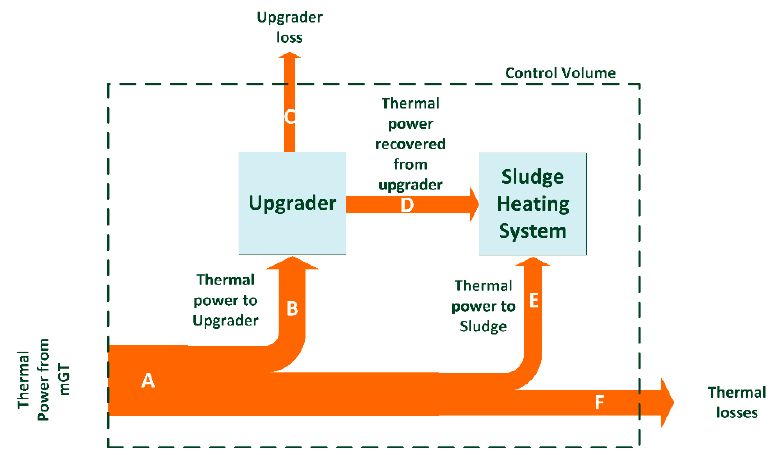
Figure 7. The thermal power flow scheme for the cogeneration system.